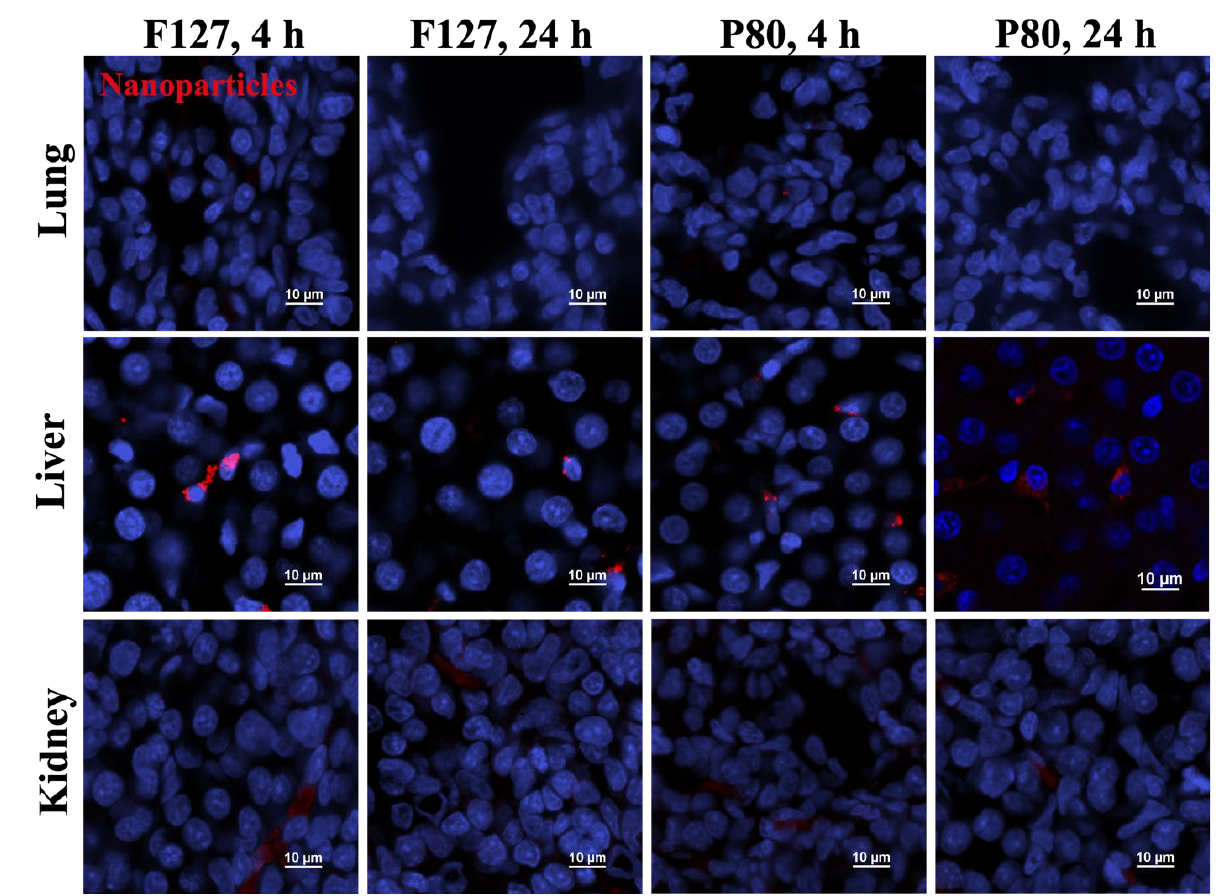
Figure 4. Tissue-level biodistribution of PLGA-PEG/F127 (F127) and PLGA-PEG/P80 (P80) nanoparticles (red) in P10 rat lung ( first row ); liver ( second row ); kidney ( third row ) at 4 h ( first and third column ) and 24 h ( second and fourth column ) after administration. Blue: DAPI nuclei stain. Scale bars: 10 µ